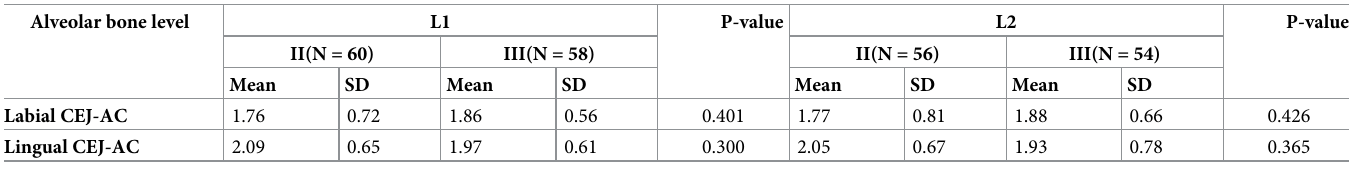
Table 4. Comparison of mandibular anterior vertical bone level between high-angle skeletal Class II malocclusion patients and high-angle skeletal Class III maloc- clusion patients (mm). Alveolar bone level